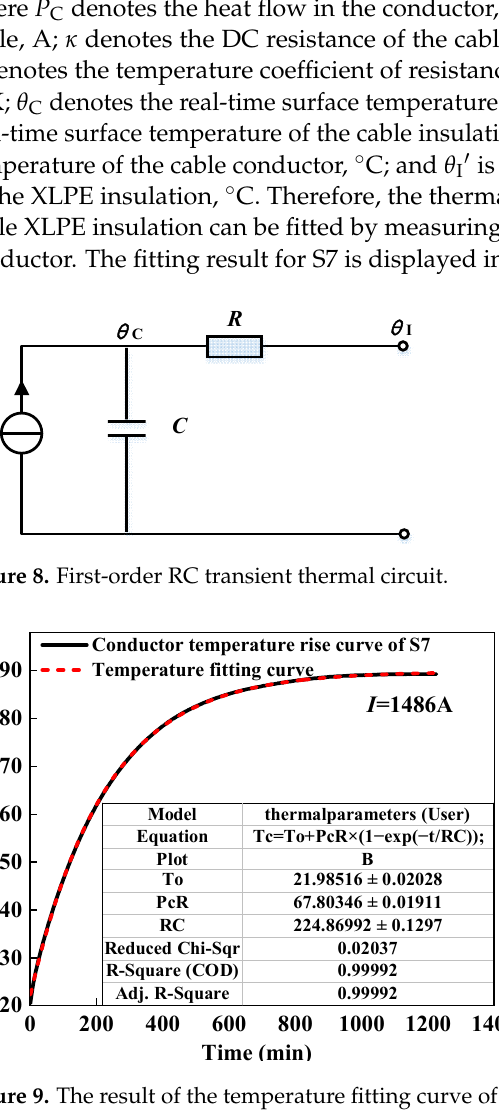
Figure 9. The result of the temperature fitting curve of S7.